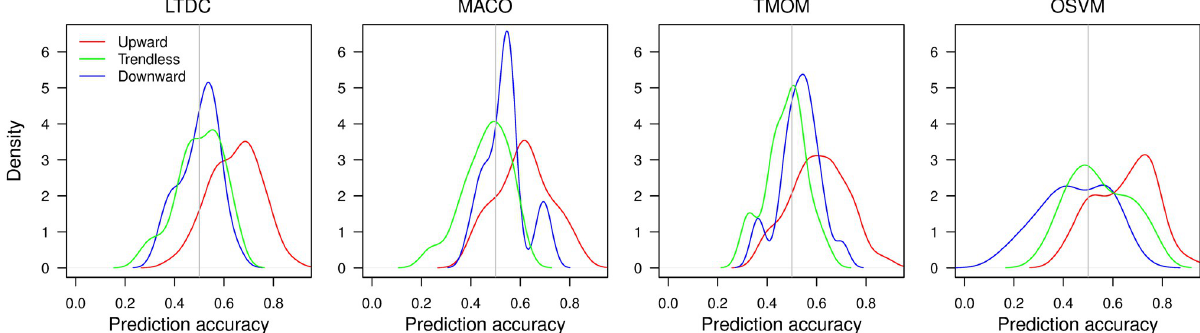
Fig 9. Kernel density estimates of price direction prediction accuracy by trend direction phase. Trend direction is classified according to yearly BHRs with the threshold at ± 0.1. The accuracy of trend-following rules is averaged over all d L values.